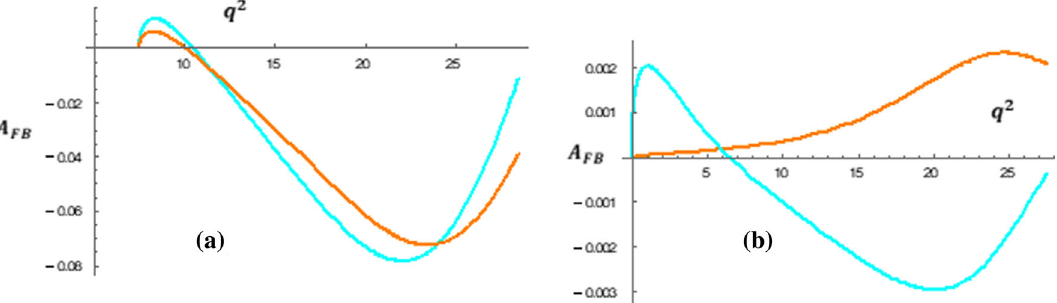
Fig. 3 Variation of forward-backward asymmetry for a B → K ∗ μ − τ + , b B → K ∗ e − μ